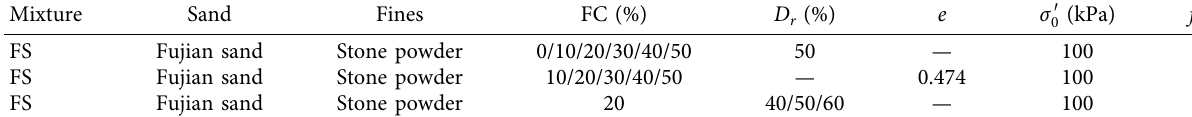
Table 2: Detailed undrained cyclic triaxial test conditions.